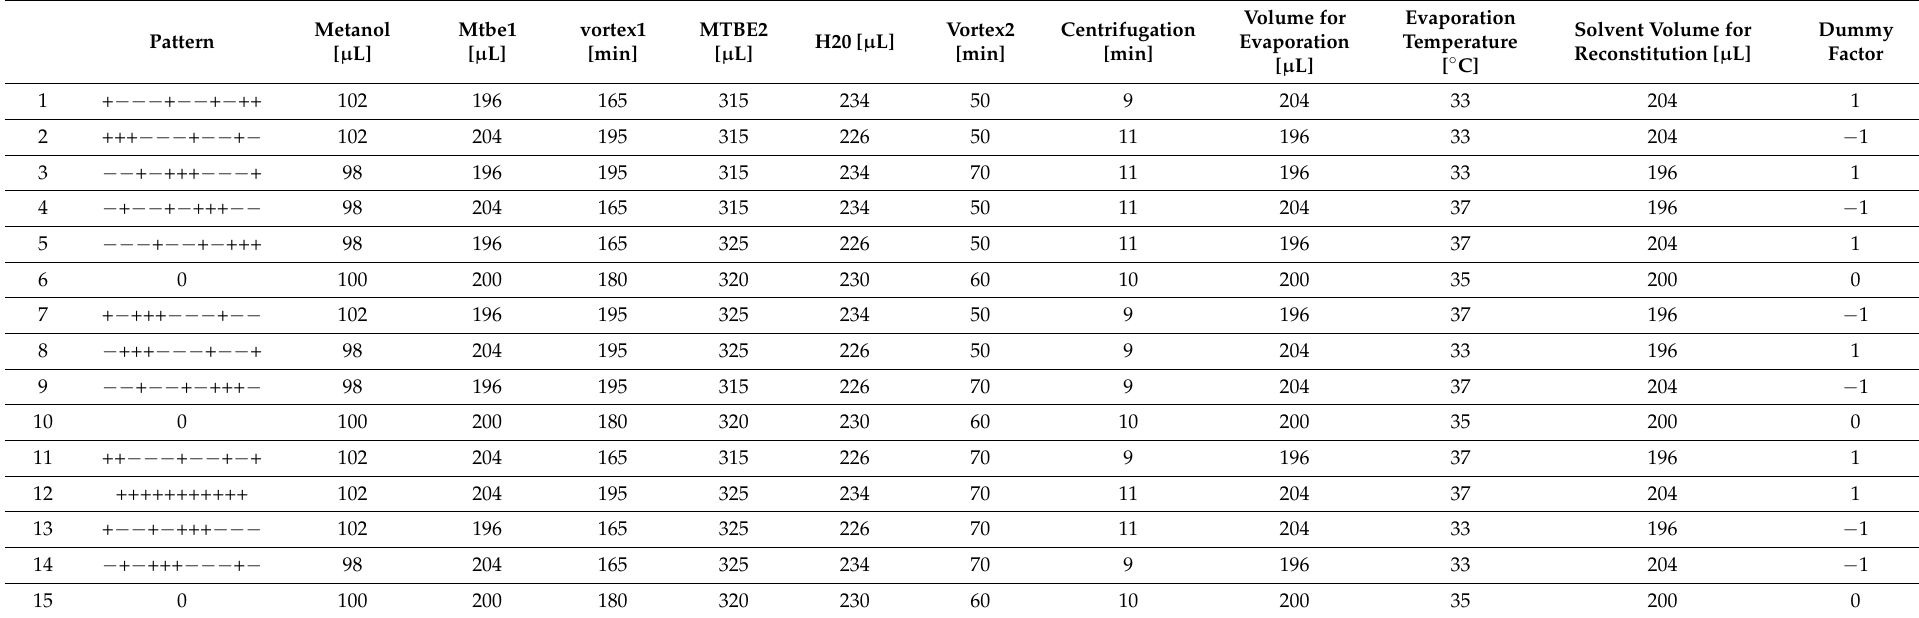
Table 1. Plackett–Burman experimental